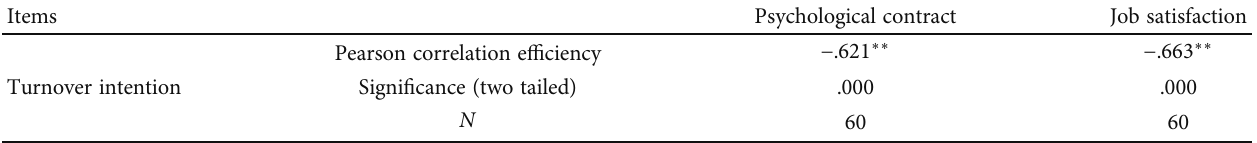
Table 4: Correlation analysis between turnover intention and psychological contract and job satisfaction.